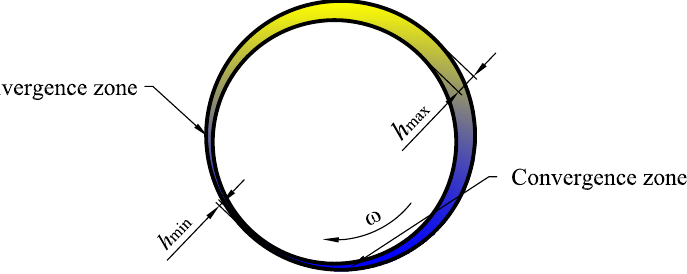
Figure 1. Schematic diagram of a radial hydrostatic bearing.